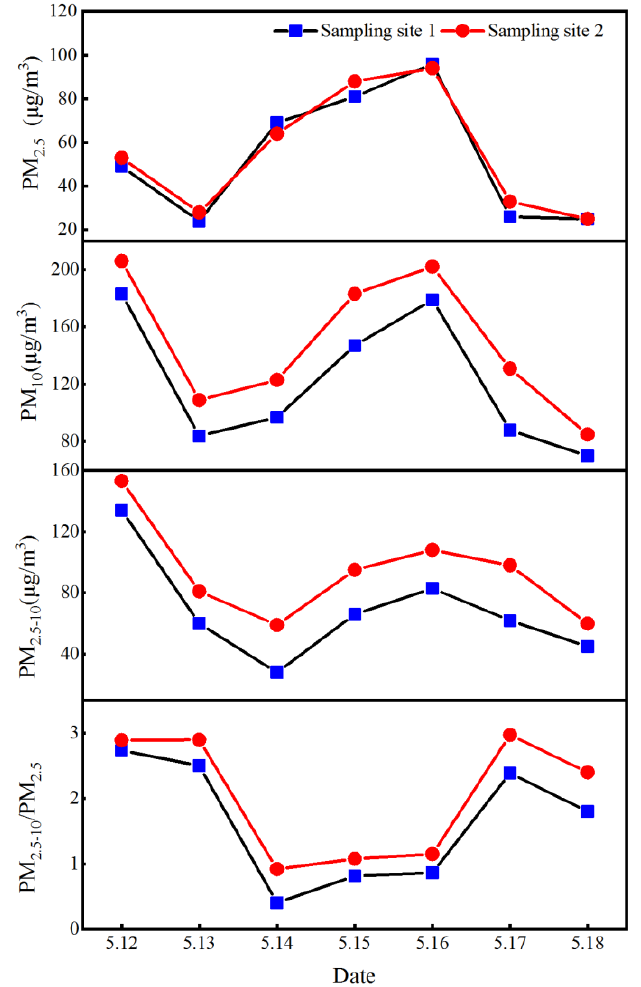
Figure 3. PM 2.5 , PM 10 , and PM 2.5–10 concentrations and changes in PM 2.5–10 /PM 2.5 at both sampling sites.